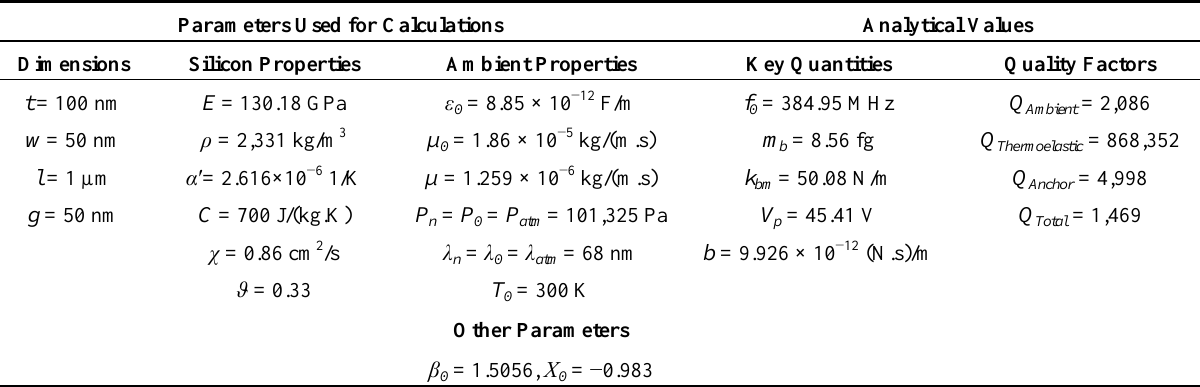
Table 1. Parameters used for calculations and the derived analytical values for nano-electro-mechanical (NEM)